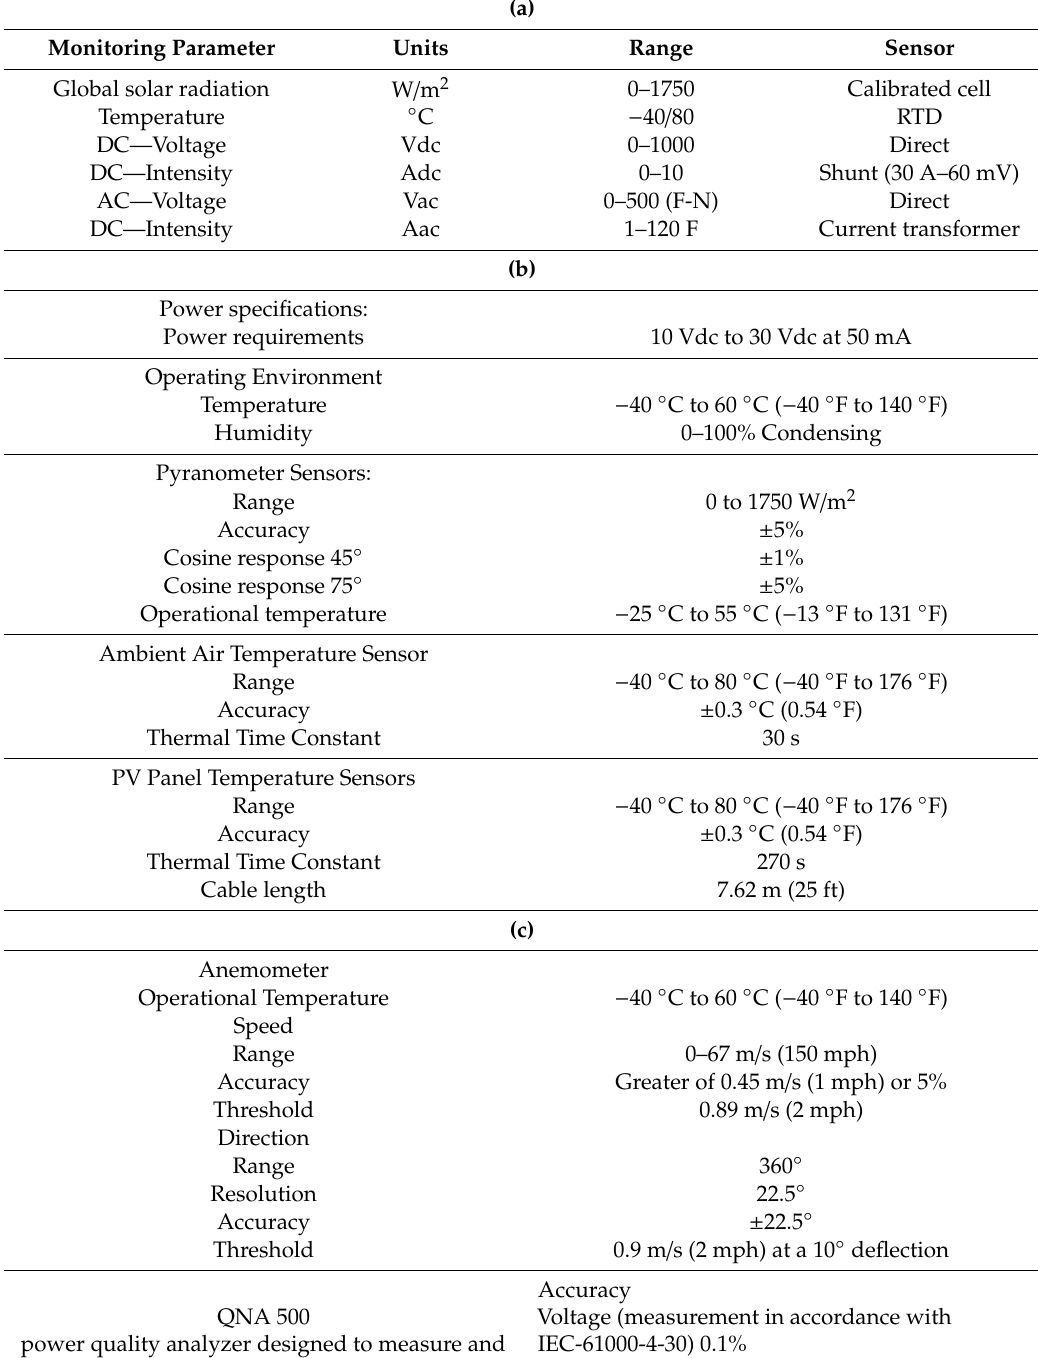
Table 3. ( a ) Measurement parameters; ( b ) hardware specifications of weather station (PVmet 200 commercial solar monitoring); ( c ) technical features of modular power quality analyzer (class